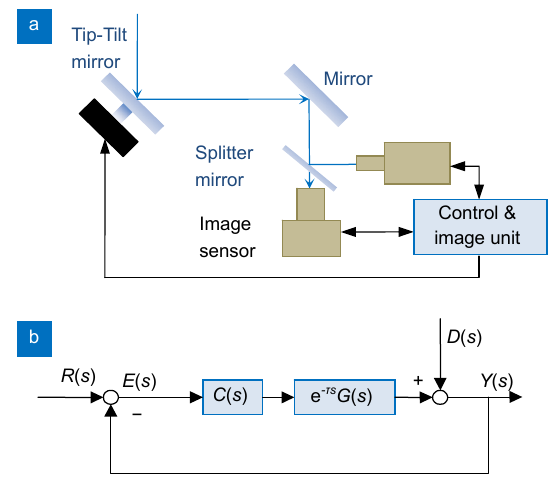
Fig. 1 | Schematic view of the Tip-Tilt mirror system. (a) Typical configuration of Tip-Tilt mirror system. (b) A typical control